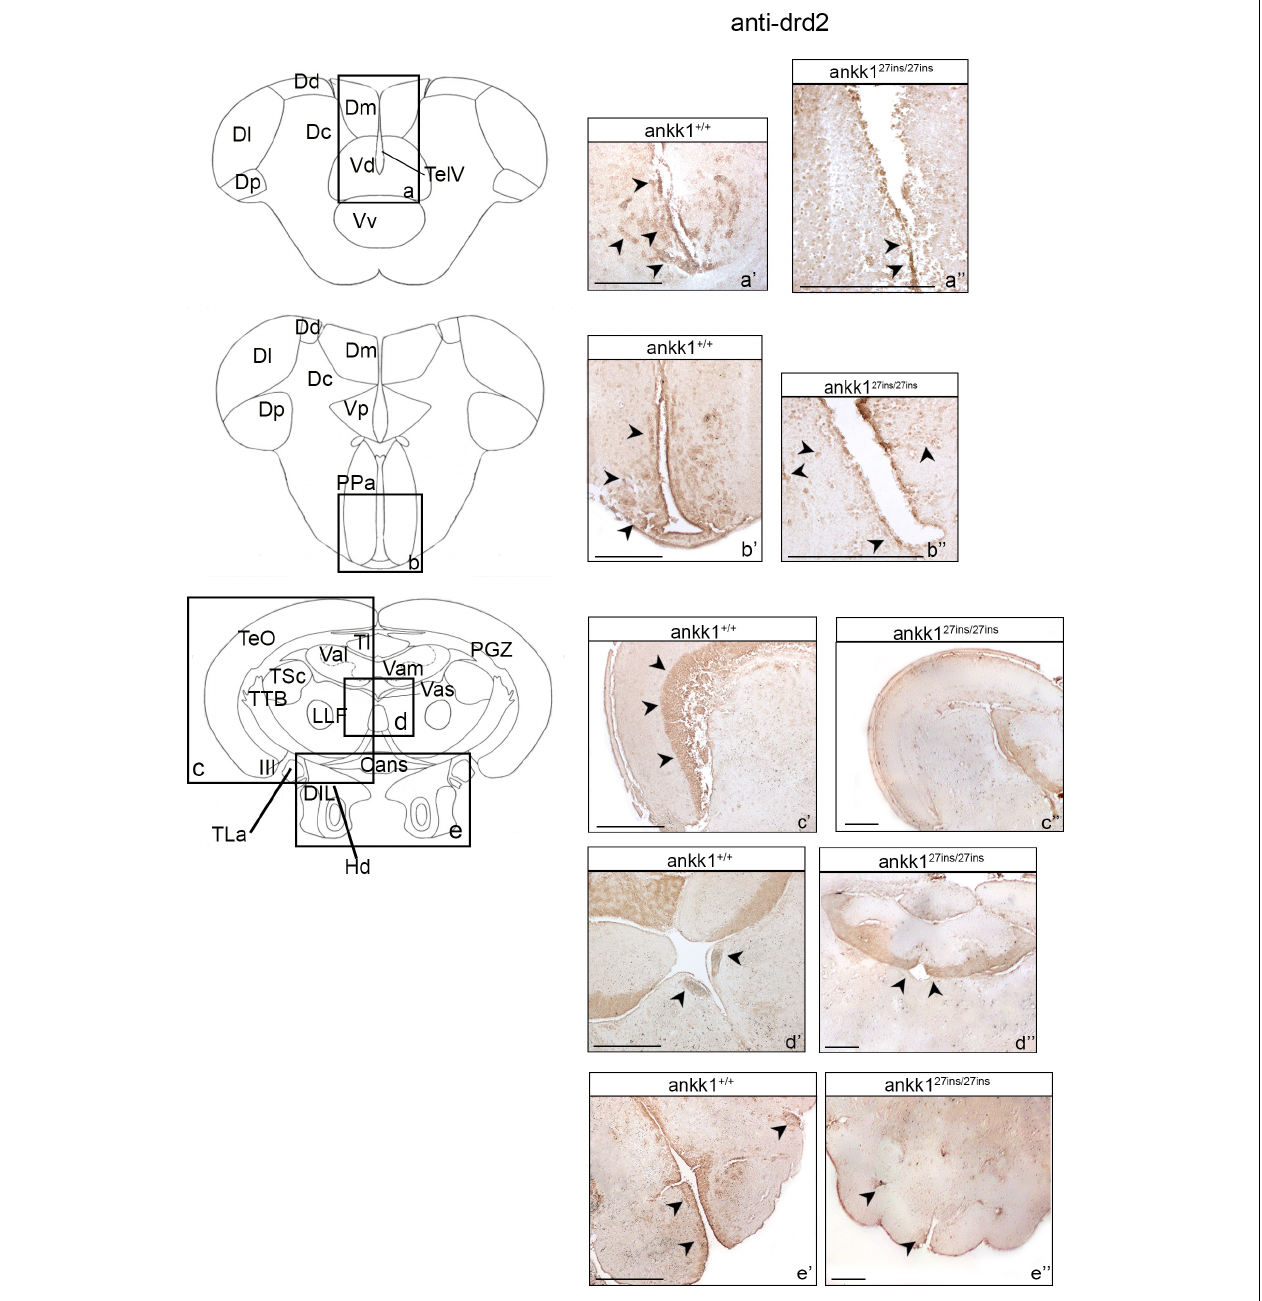
FIGURE 4 | Drd2 immunohistochemistry in adult zebrafish brain. On the right, drd2 protein distribution in transverse sections of zebrafish brain, ankk1 + / + and ankk1 27 ins / 27 ins . On the left, schematic depiction of zebrafish brain, transversal section [adapted from Wullimann et al. (1996)]. (a–e) Boxes on the schematic depictions represent the region of the brain showed by the corresponding immunohistochemistry on the right; (a’–b”) forebrain drd2 staining; (c’–e”) midbrain drd2 staining. Scale bars: (c”,d”,e’) , 50 mm; (a’–e’) , 100 mm; (b”) , 200 mm. Arrows indicate anti-drd2 positive cells.